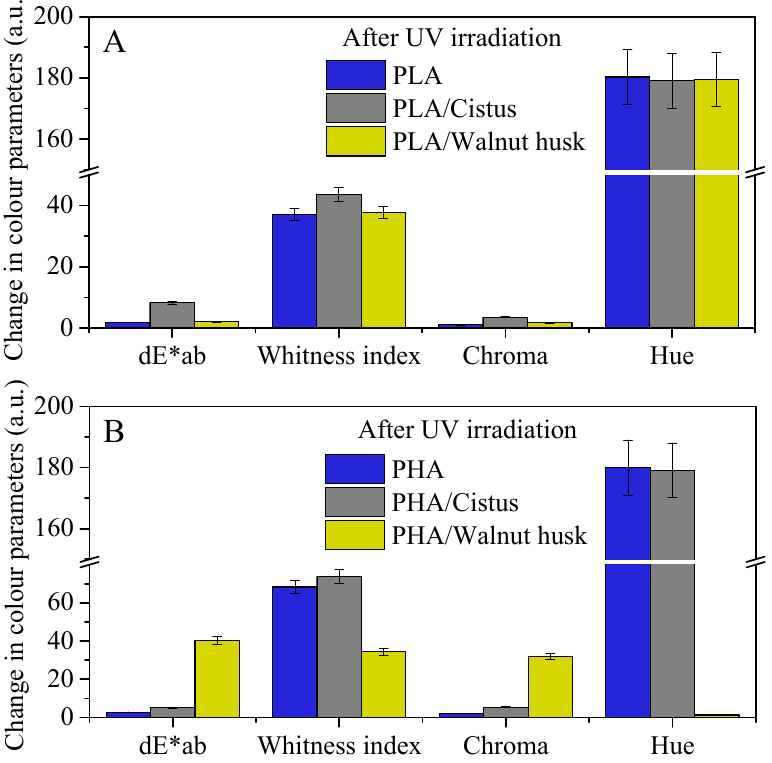
Figure 7. ( A ) Change of parameters of color PLA samples after UV irradiation. ( B ) Change of parameters of color PHA samples after UV irradiation.